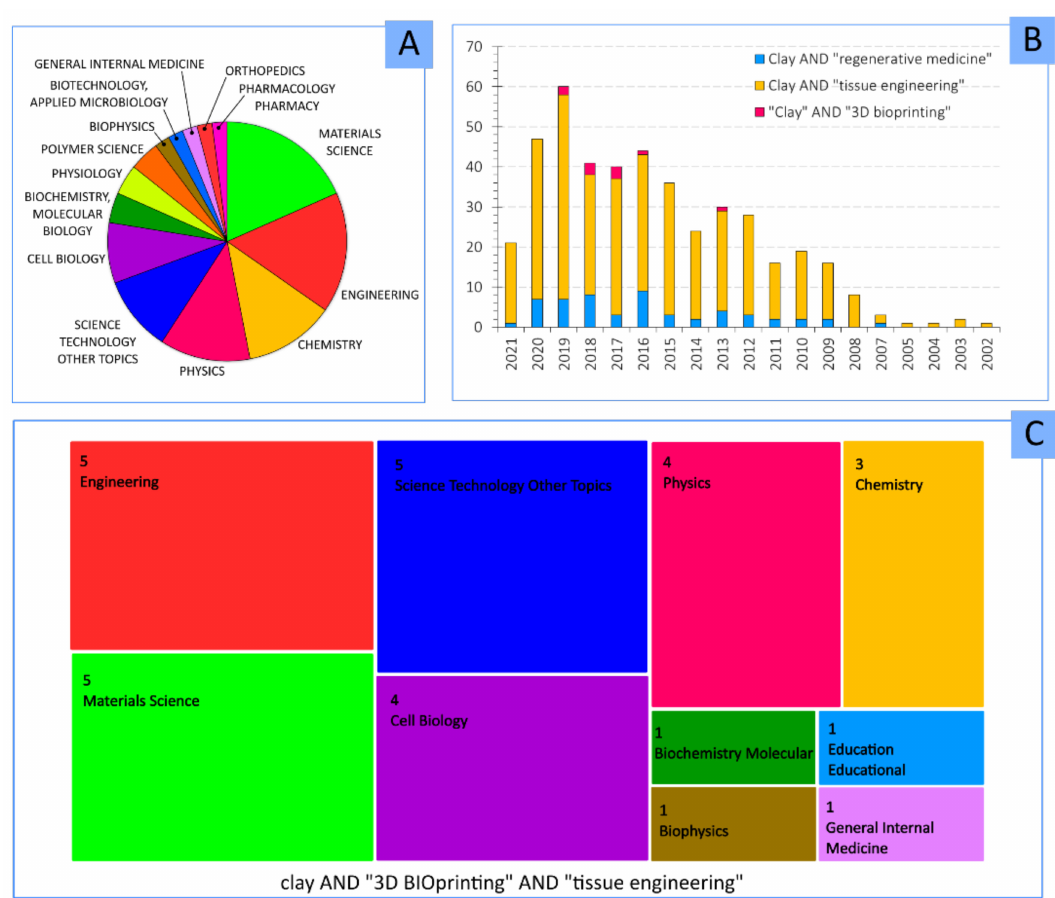
Figure 7. ( A ) Most important research areas of studies dealing with “clay” AND “3D Bioprinting”. ( B ) Number of publications per year containing “clay”, “3D bioprinting”, “regenerative medicine” and “tissue engineering” keywords. ( C ) Main research areas for “clay” AND “3D bioprinting” AND “tissue engineering”. Results obtained from database Web of Science, June